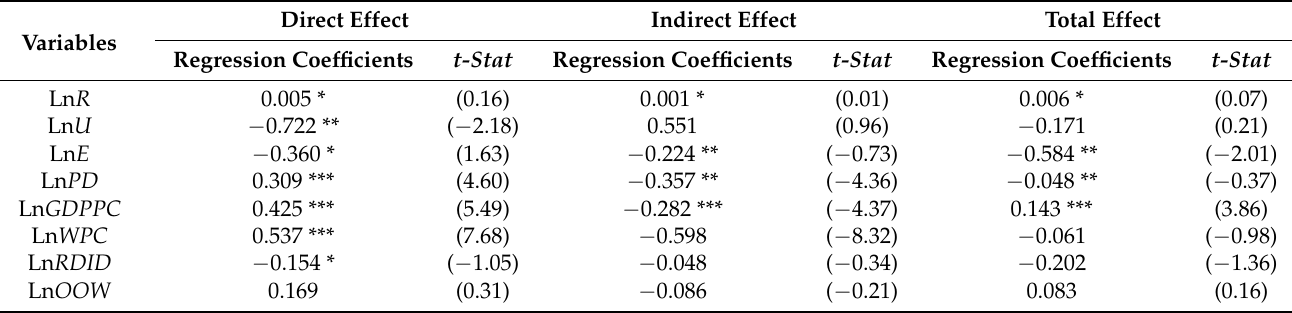
Table 3. The decomposition results of spatial